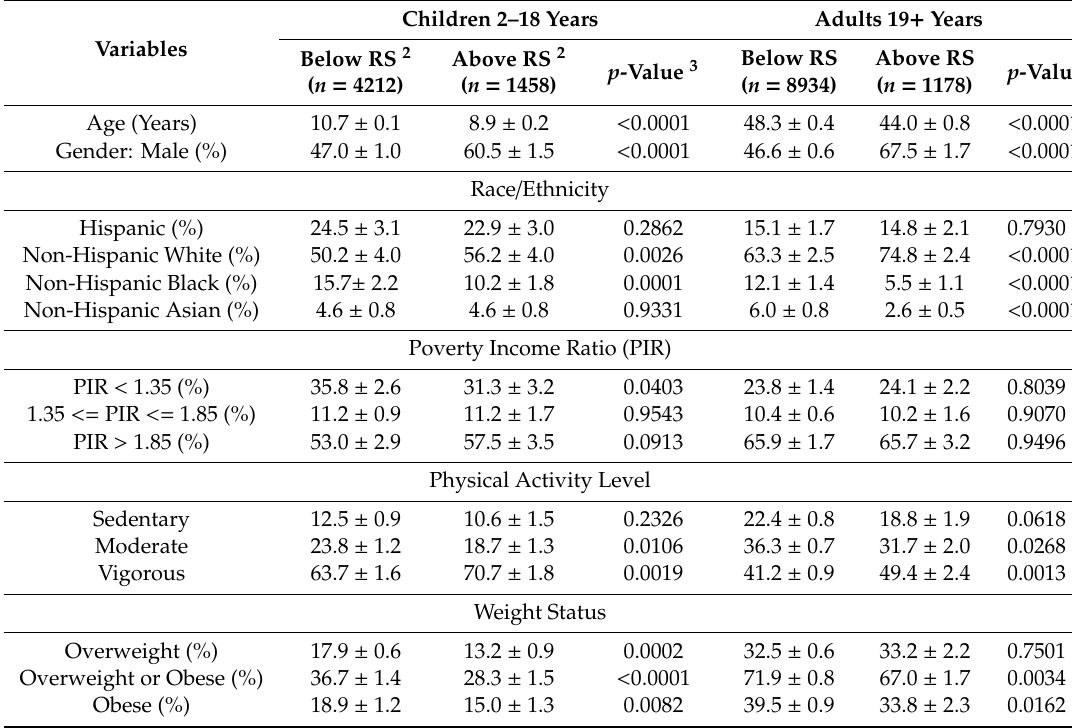
Table 2. Demographic characteristics of U.S. subpopulations consuming above recommended daily servings of dairy foods and those consuming fewer than the recommended daily servings of dairy foods in the National Health and Nutrition Examination Survey 2013–2016 1